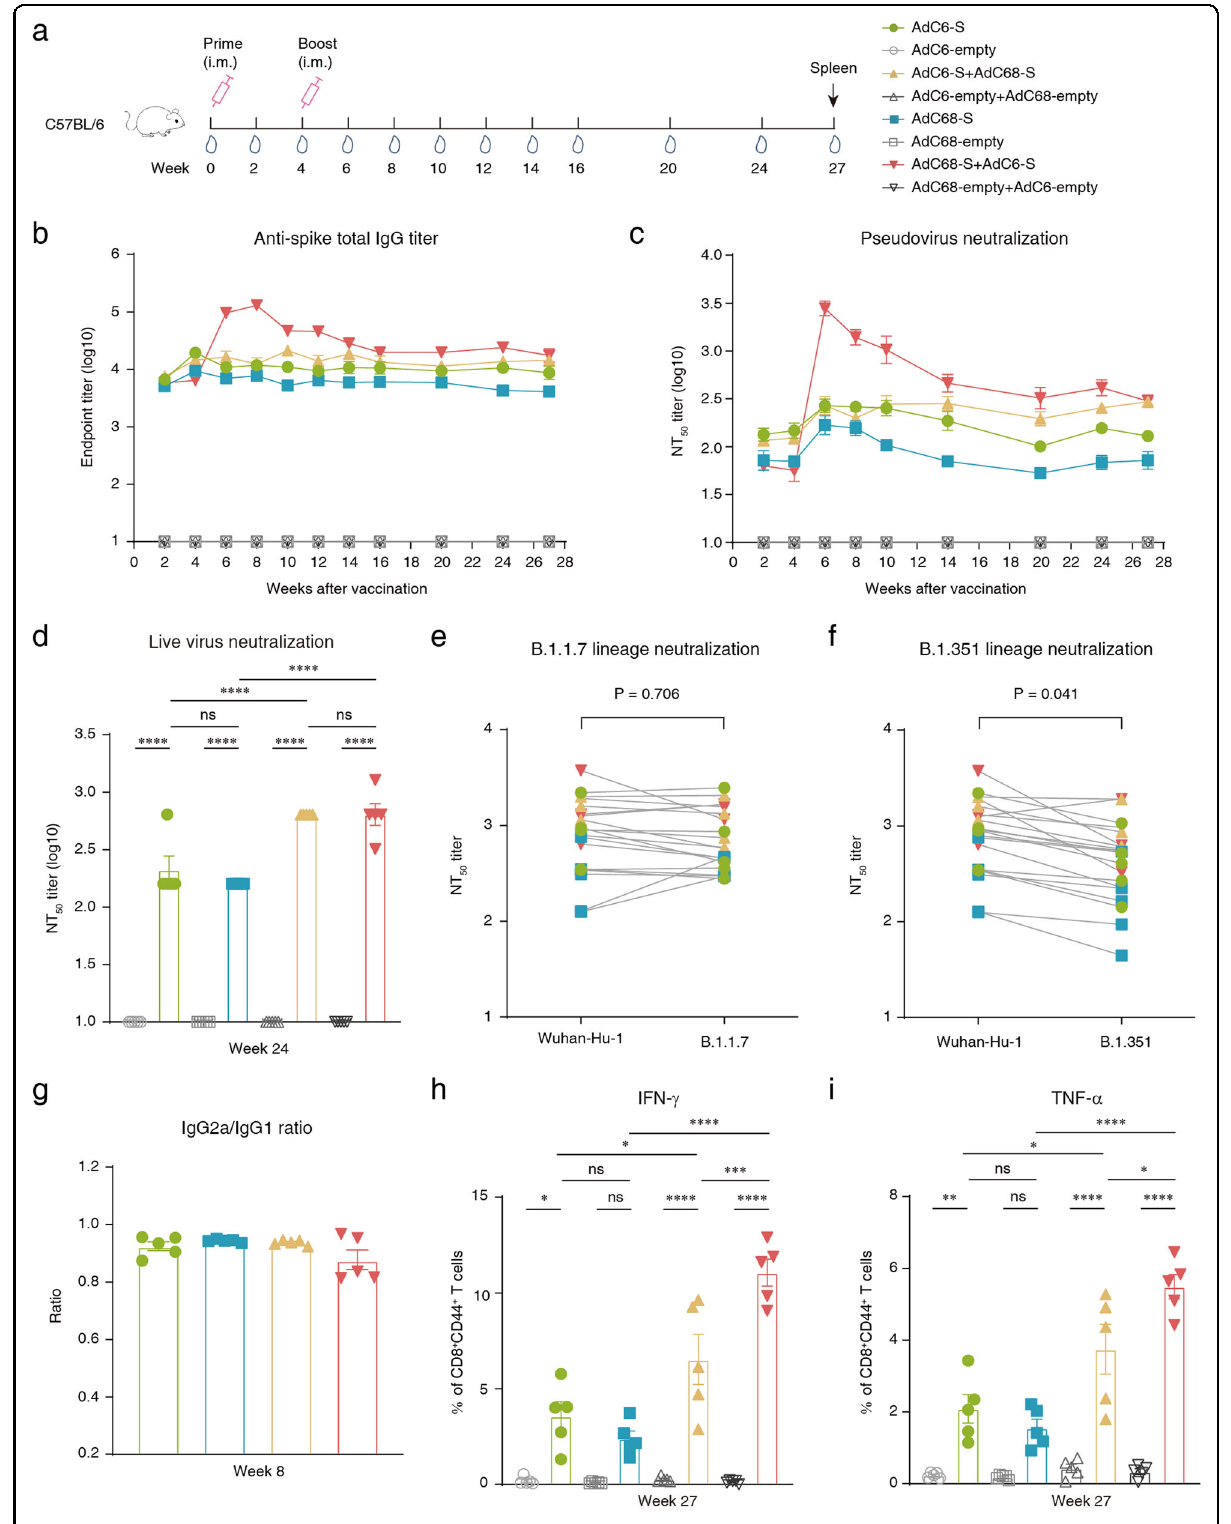
Fig. 1 (See legend on next